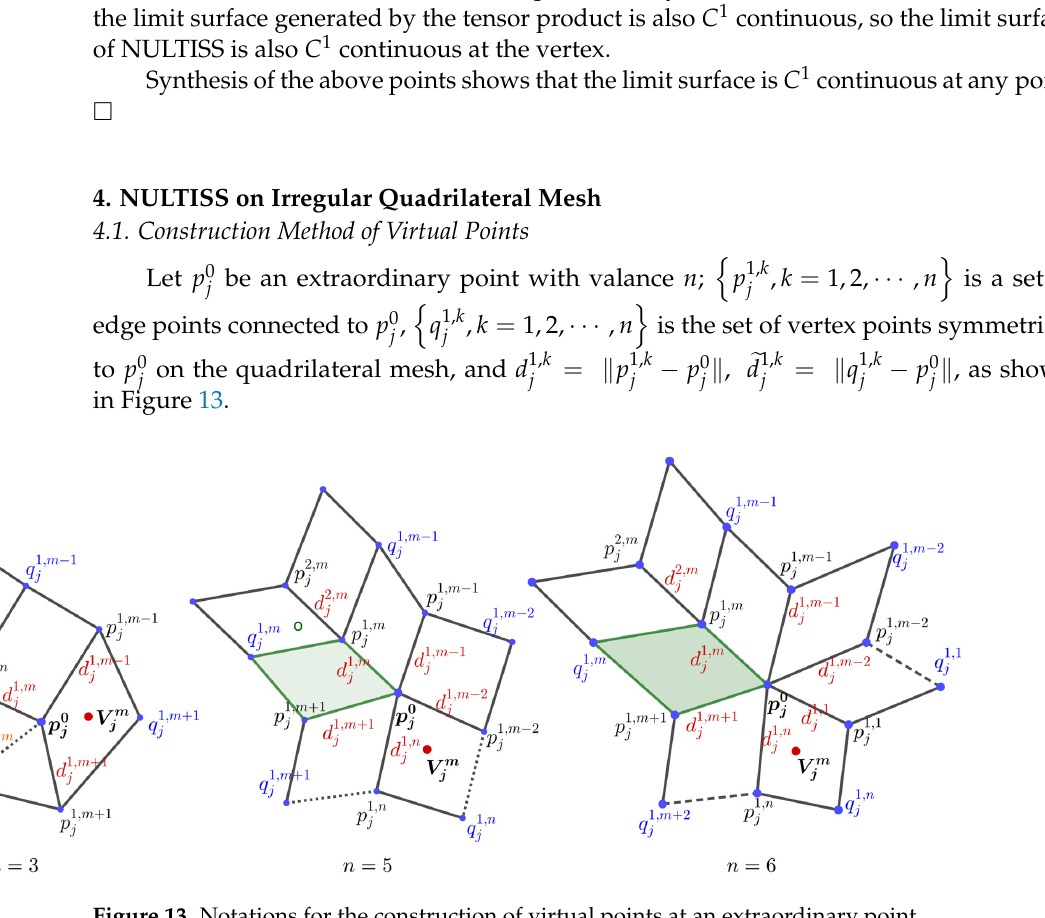
Figure 12. Notations for the continuous proof at a regular vertex.